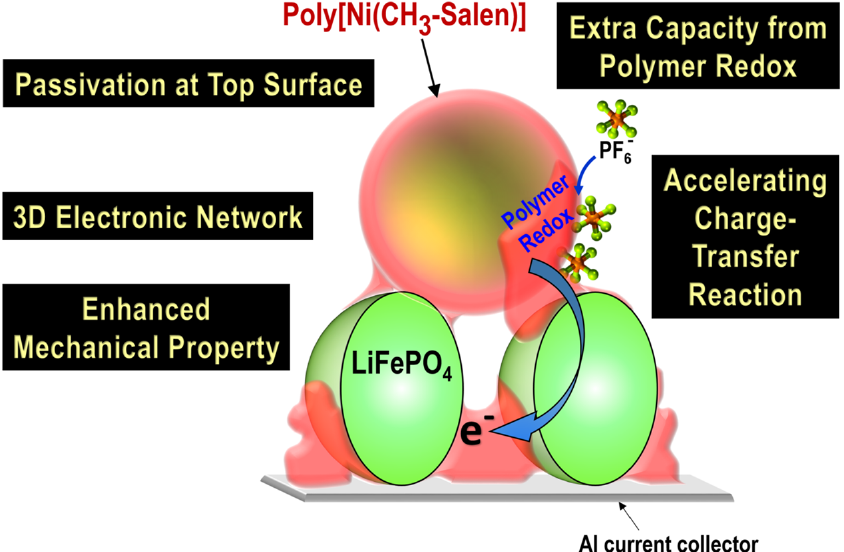
Figure 9. Multiple Roles of Poly[Ni(CH 3 -Salen)] in Carbon-Free Cathodes: (i) formation of 3D elec- tronic network, (ii) accelerate charge-transfer reaction of cathode, (iii) providing extra capacity from the redox of poly[Ni(CH3-salen)], thus increasing energy density at cathode level, (iv) enhanced mechanical property as a binder for cathodes, and (v) passivation of active materials at top surface. The direction of electrochemical reactions is for a battery-charging process [99]. Reprint with permission from [99]. Copyright 2019, American Chemical Society.